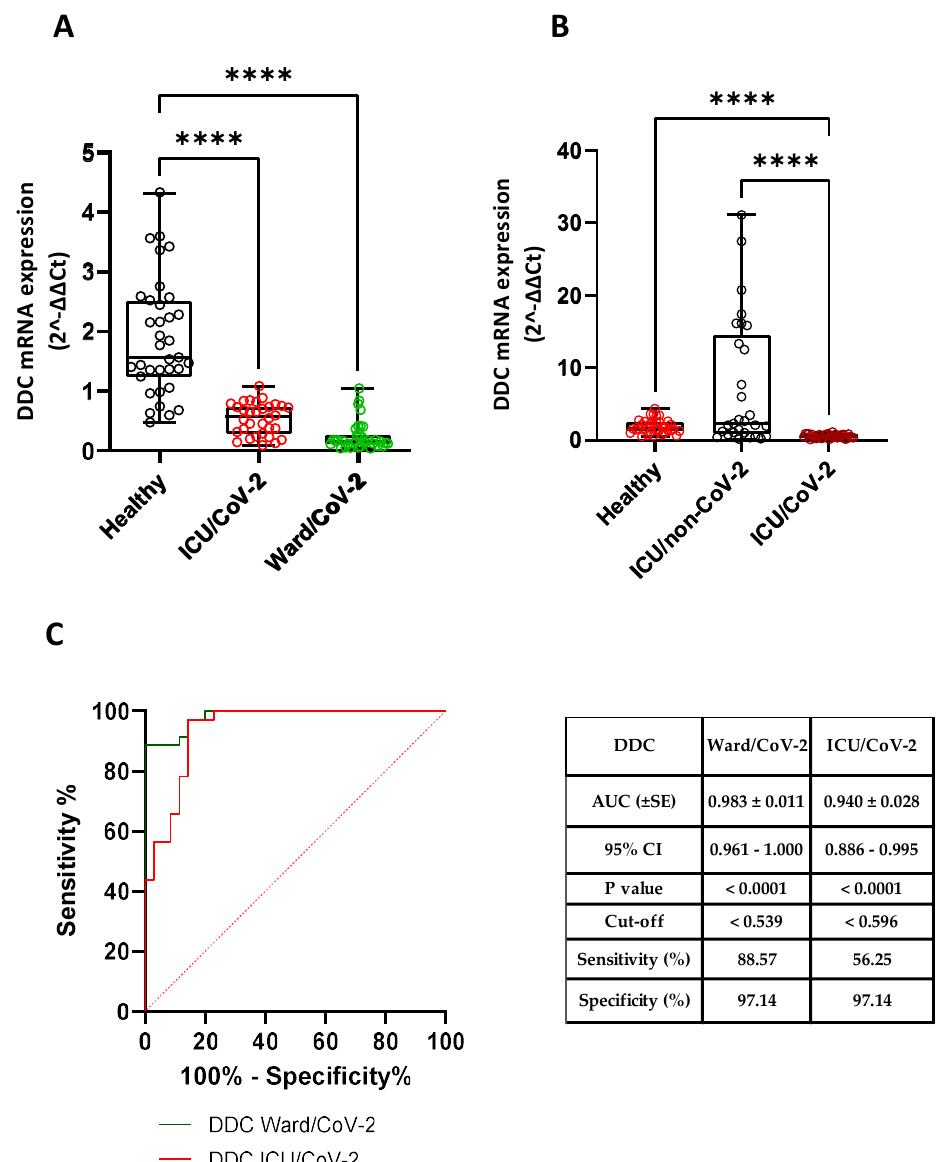
Figure 4. Comparison of the mRNA levels (mean 2 − ∆∆ Ct ) of DDC in whole blood samples in: ( A ) COVID-19 patients hospitalized in the intensive care unit (ICU/CoV-2, n = 32) or the ward (Ward/CoV-2, n = 30) and healthy subjects (Healthy, n = 30) ( B ) Healthy subjects and hospitalized patients in the ICU either infected with SARS-CoV-2 (ICU/CoV-2) or not infected (ICU/non-CoV-2, n = 30) ( C ) ROC curve analysis of DDC expression in the ICU/CoV-2 and Ward/CoV-2 patient cohorts. Data are displayed as box plots and dots; the line in the middle corresponds for the median value; box edges, 25th to 75th centiles; whiskers, range of values. p -values were calculated with the Kruskal–Wallis test. Dunn’s test was performed for multiple comparisons. ROC curves were generated, and AUC, 95% CI, p -values, and cut-off points with their specificity and sensitivity were reported. The red dotted line denotes perfect chance (positive likelihood ratio = sensitivity/(1-specificity) =1). **** p < 0.0001.